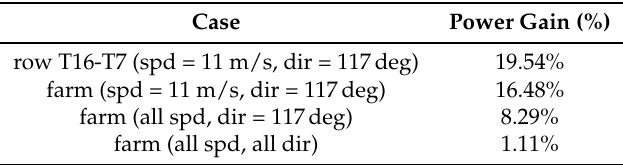
Figure 6. Relative power production increase for wake redirection as function of the wind direction. Table 2. Power gain for wake